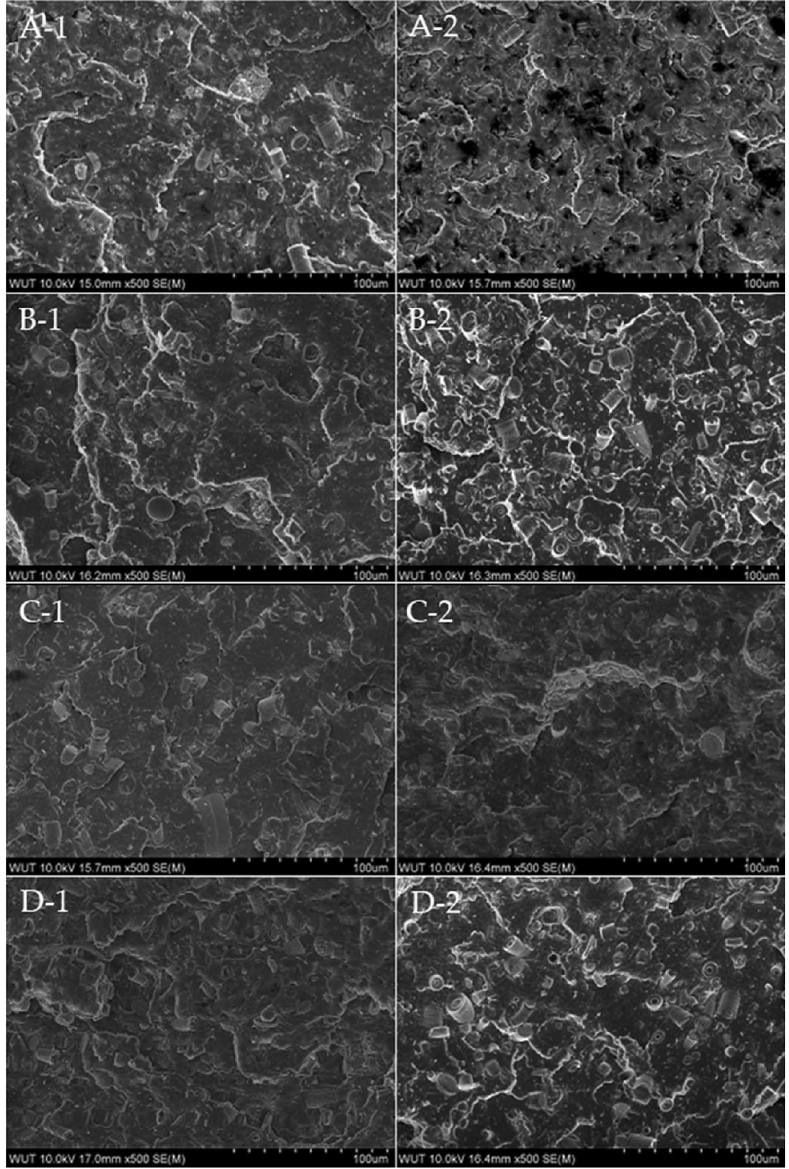
Figure 13. SEM images of composites; ( A-1 ) 10B, ( A-2 ) 15B, ( B-1 ) 10B/0.5BW, ( B-2 ) 15B/0.5BW, ( C-1 ) 10B/1BW, ( C-2 ) 15B/1BW, ( D-1 ) 10B/0.5SW, ( D-2 )